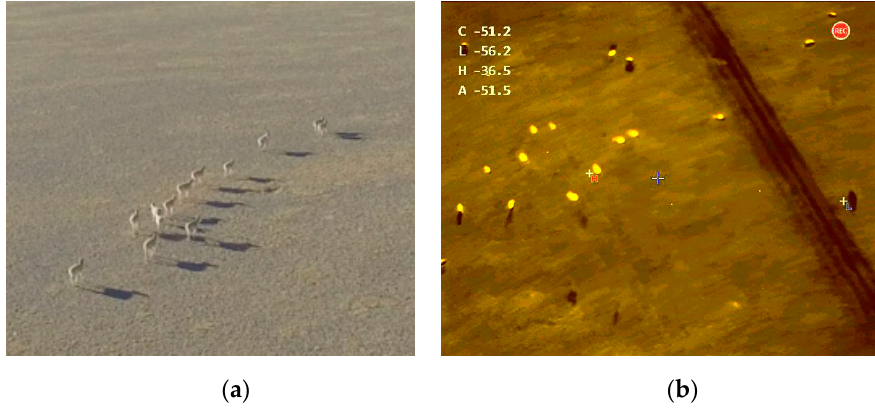
Figure 20. Different payloads for endangered animals: ( a ) Optical image, ( b ) infrared image.